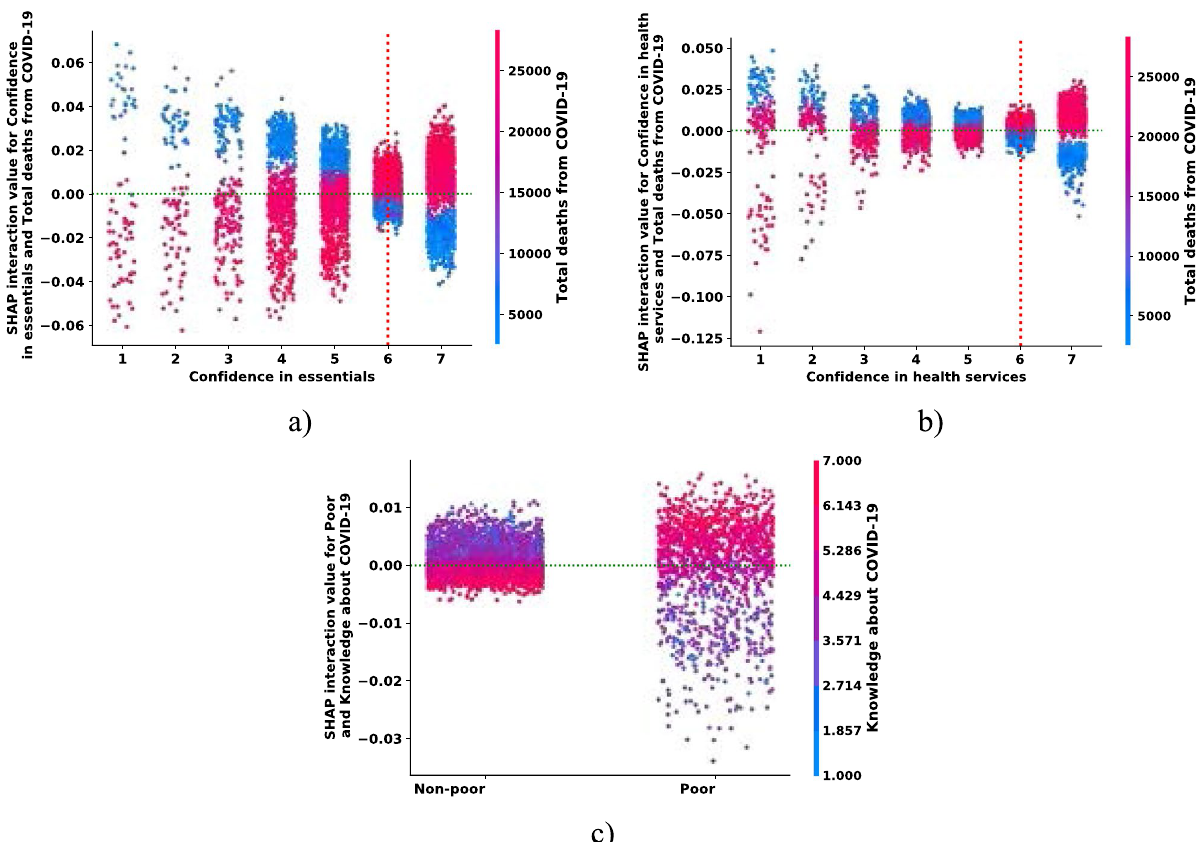
Figure 7. Feature interaction effects. Notes : Each panel ( a )–( c ) displays SHAP feature dependence plots of the RF model with the largest interaction effect. Artificial jitter (0.5) was added along the x-axis to better show the overlapping distribution of the